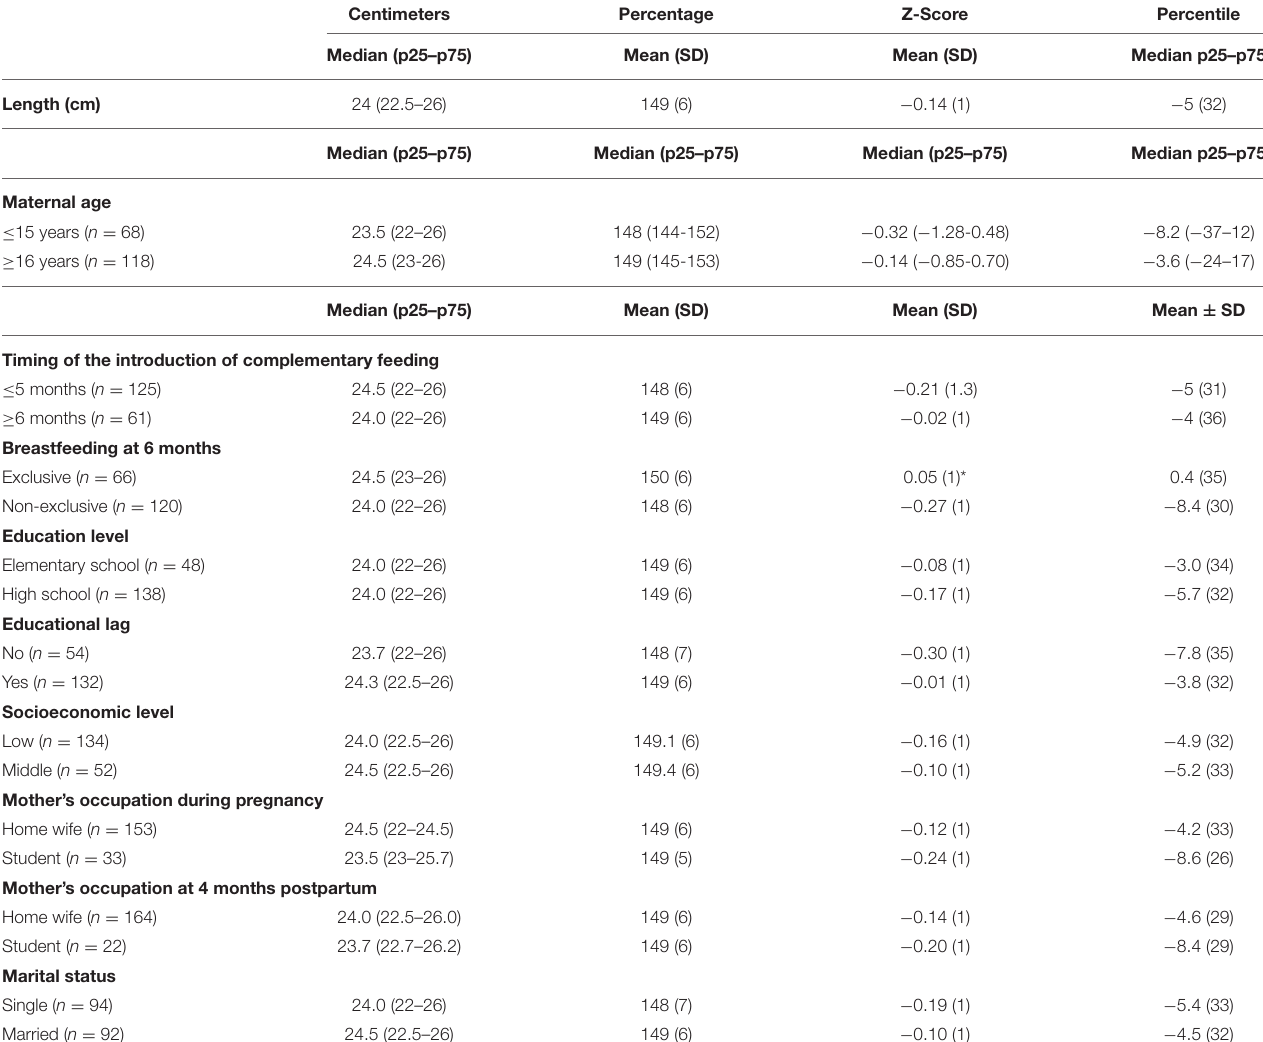
TABLE 3 | Change of length (delta) according to sociodemographic